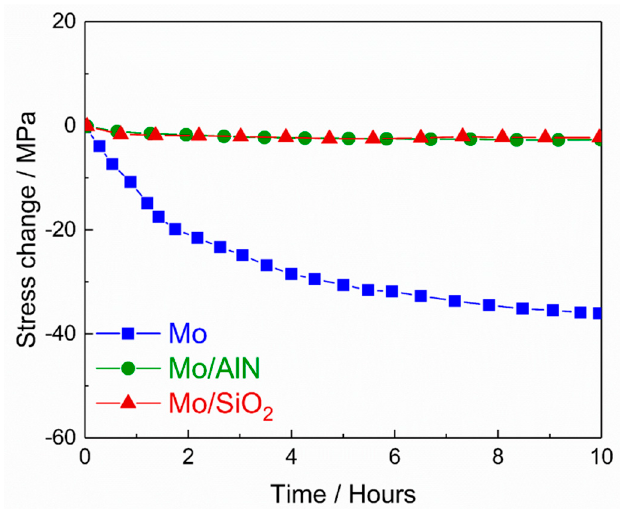
Figure 5. Isothermal measurements of the stress at 600 °C for the preannealed uncovered and covered Mo films (with AlN or SiO 2 layer).